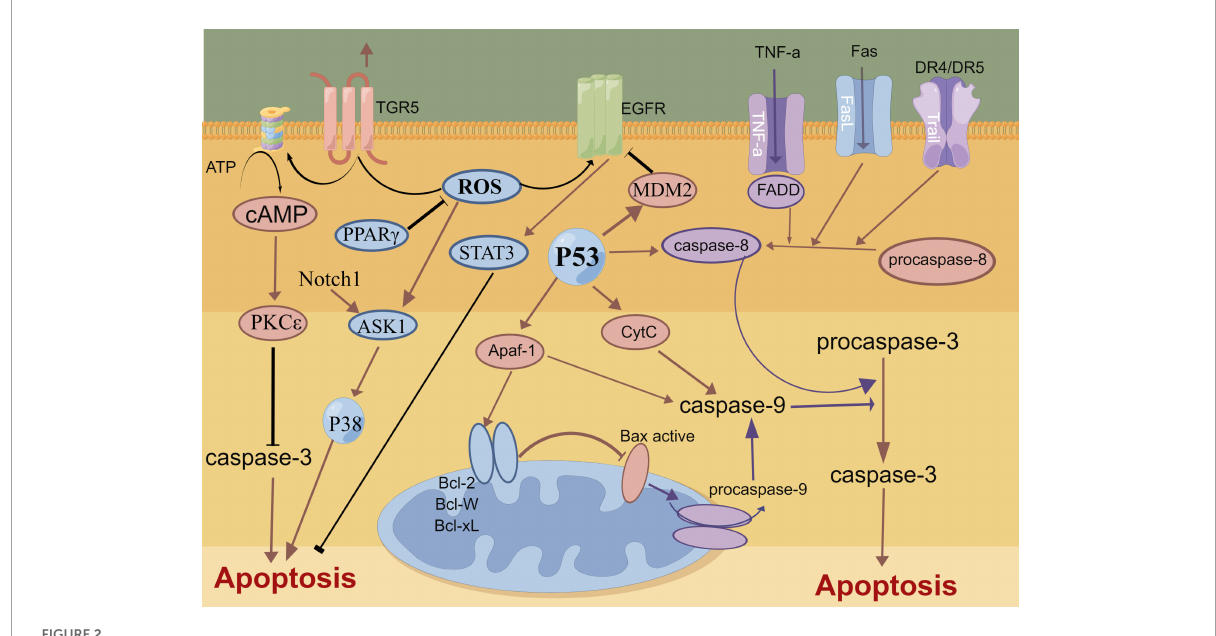
FIGURE2 Molecular mechanisms of apoptosis from subarachnoid hemorrhage to early brain injury (EBI).